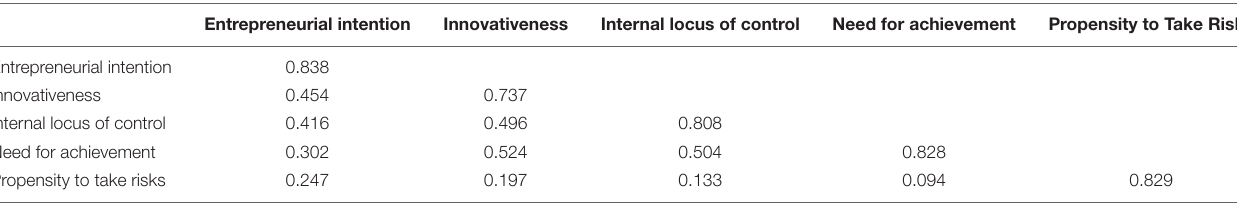
TABLE 4 | Fornell–Larcker